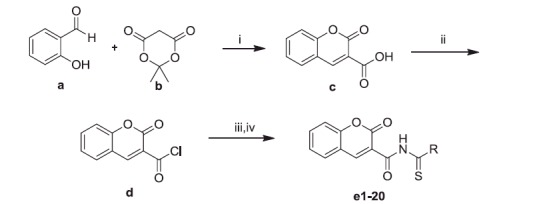
Synthesis of new thiourea substituted coumaryl-carboxamid derivatives. Reaction conditions: (i) H2O, reflux, 10 h; (ii) SOCl2, 80 °C, 4 h; (iii) KSCN, CH3CN, 70 °C, 30 min.; (iv) RNH2, 70 °C, 4 h.